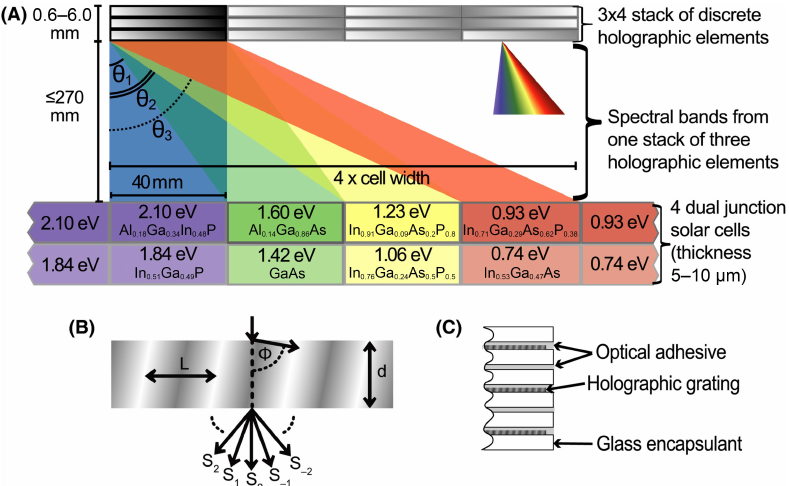
Figure 1. ( A ) Stacks of discrete holographic elements (a single stack is described in part ( C )) generate four spectral bands coupled into one of four dual-junction solar cells, including GaAs. Part ( B ) shows the volume phase hologram of thickness d with fringes representing the refractive index with periodicity L , tilted to the grating normal by angle φ , where incident light is split into diffracted orders S i